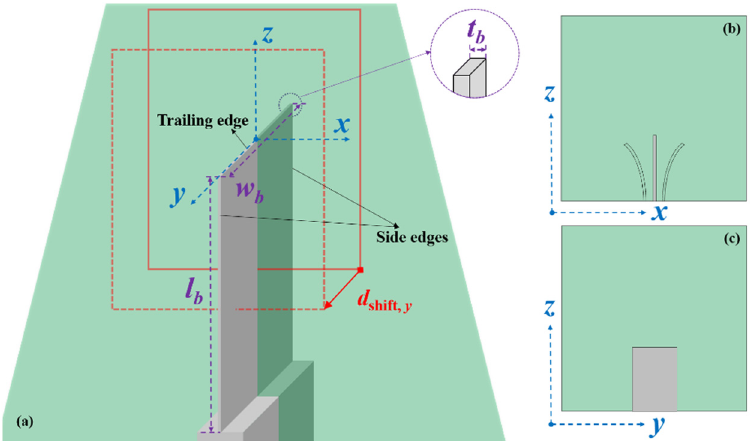
Figure 2. Geometry parameters of the PZT fan blade and the illuminated plane for the PIV measurement, with frame ( a ) showing geometry parameters ( b ) showing the transverse plane ( x – z plane) and frame ( c ) showing the longitudinal plane ( y – z plane).